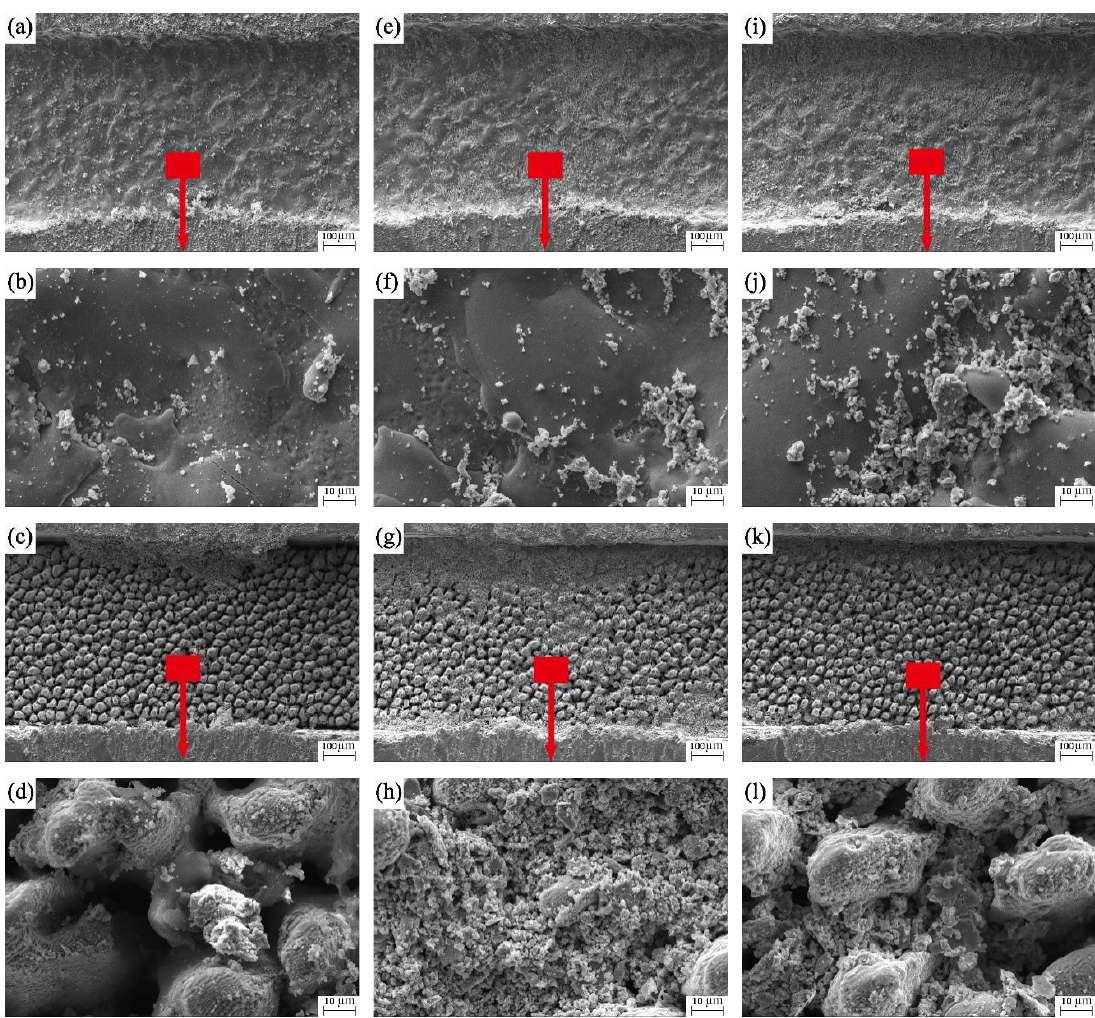
Figure 15. SEM images of the groove-textured worn plates: ( a , b ) electric-spark texture rotation radius 15 mm; ( e , f ) electric-spark texture rotation radius 18 mm; ( i , j ) electric-spark texture rotation radius 22.5 mm; ( c , d ) femtosecond texture rotation radius 15 mm; ( g , h ) femtosecond texture rotation radius 18 mm; ( k , l ) femtosecond texture rotation radius 22.5 mm.